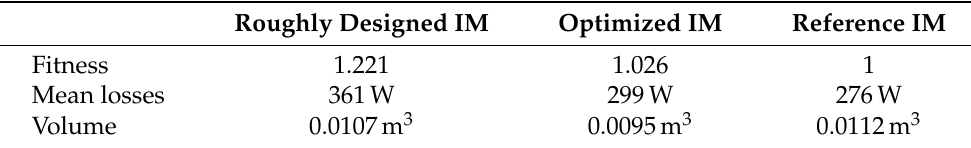
Table 5. Fitness values and decision parameters resulting from the